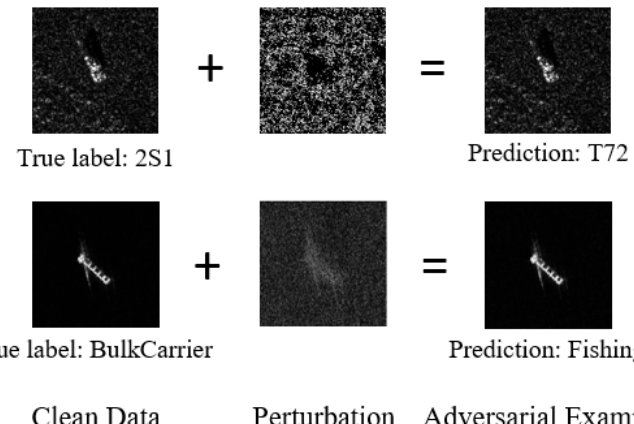
Figure 1. Illustration of adversarial attacks on DNN models for SAR target recognition. The perturbations are amplified ten times for ease of observation.